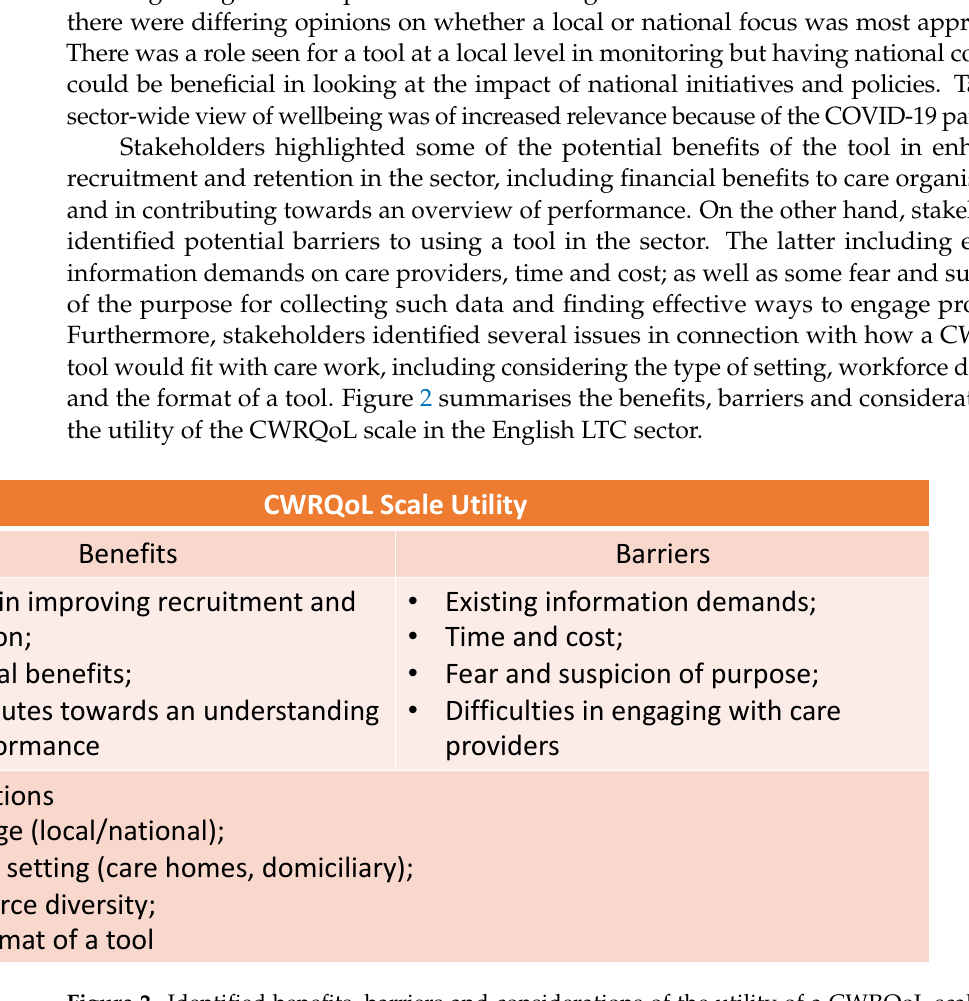
Figure 2. Identified benefits, barriers and considerations of the utility of a CWRQoL scale in the English LTC sector, Stage 2 stakeholders’